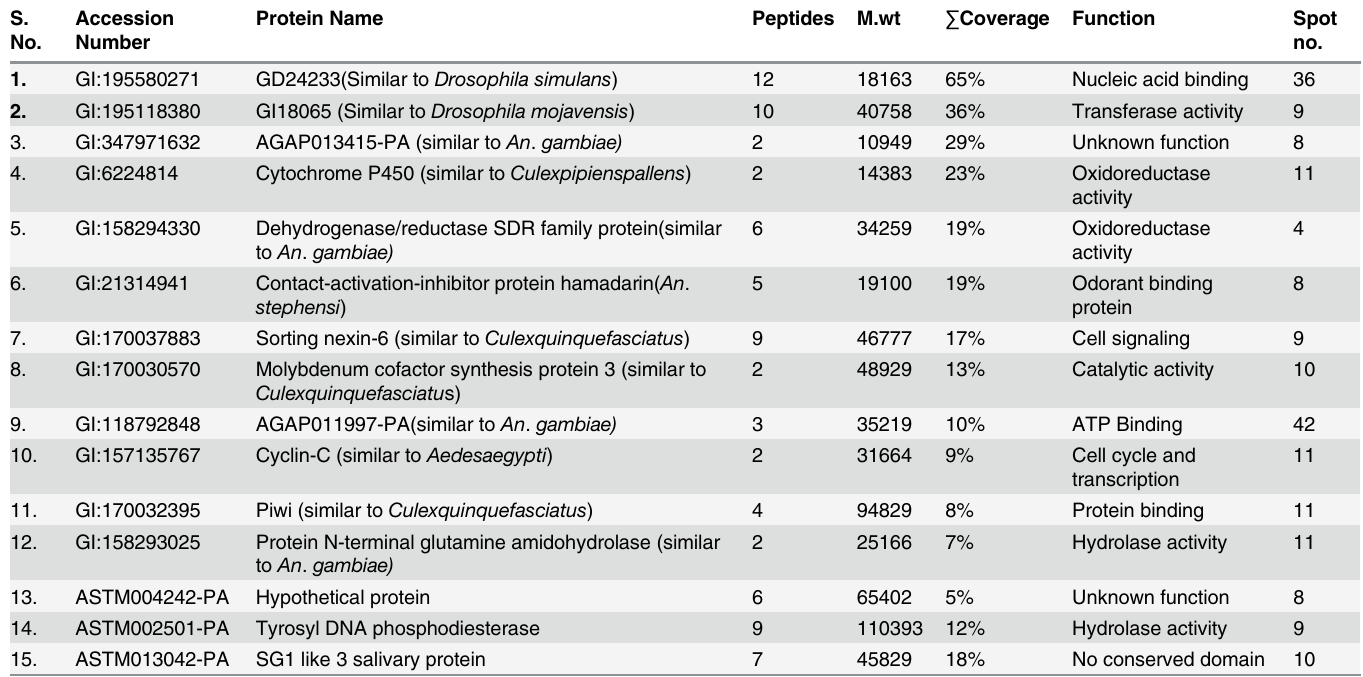
Table 2. Summary of upregulated salivary proteins identi fi ed in the SGE of An . stephensi multi resistant strain by MALDI-TOF MS/MS. S.